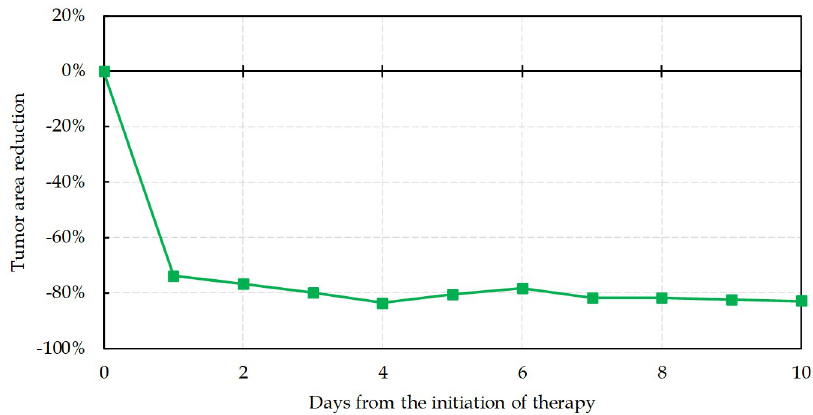
Fig 19. Tumor area percent reduction during 10 days of treatment in comparison with the 25000 μ m 2 baseline area. Blocking the pathways kills cancer cells and prevents tumor growth.